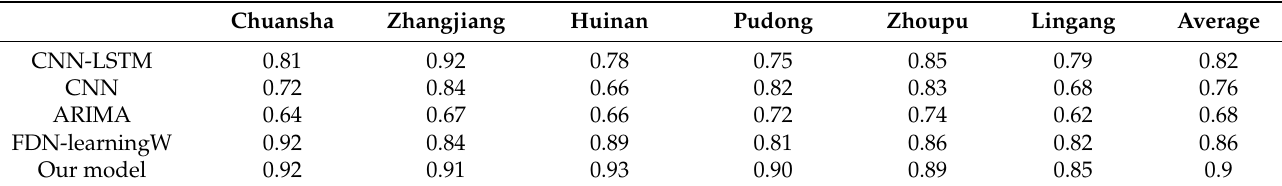
Table 6. Performance comparison of different models on